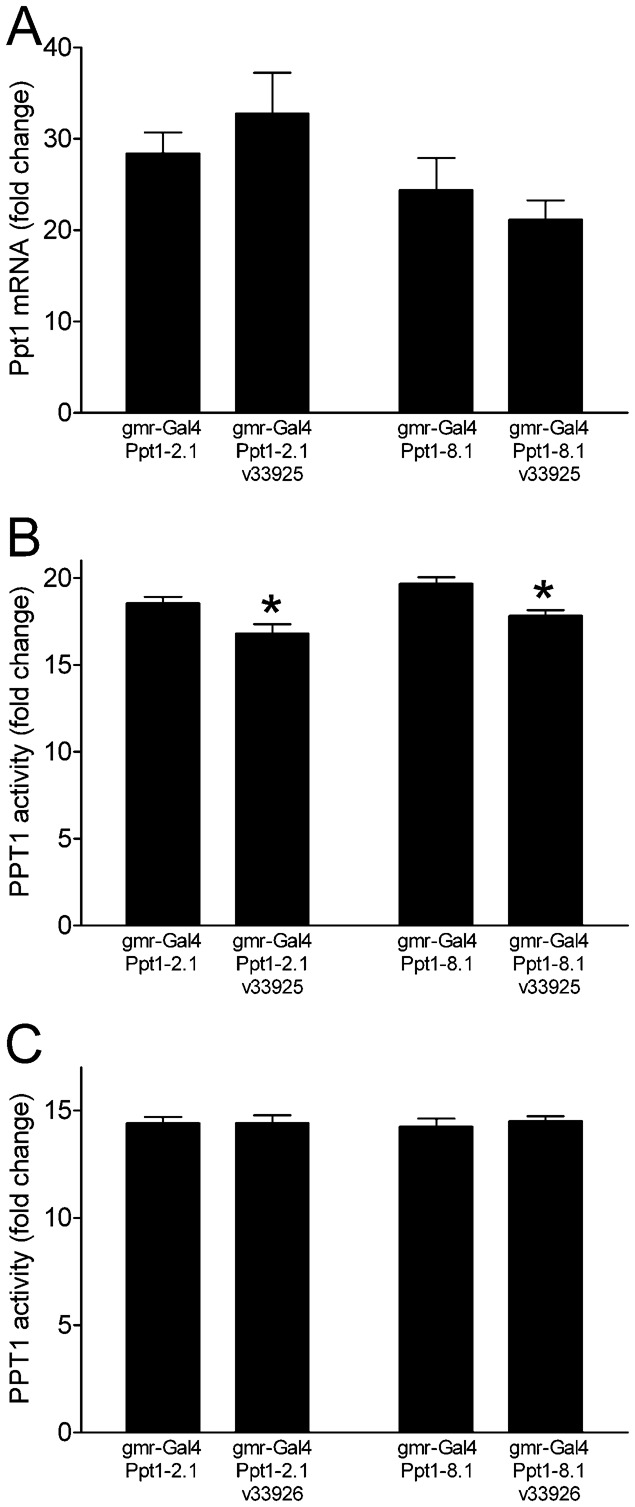
Effect of RNAi-mediated knockdown of cisd2 on Ppt1 mRNA expression and enzyme activity.(A) Expression of v33925 did not alter total head Ppt1 mRNA expression (individual t tests, n.s., n = 4). (B,C) PPT1 enzyme activity in fly heads. (B) Co-expression of the v33925 RNAi transgene with Ppt1-2.1 or Ppt1-8.1 decreased PPT1 enzyme activity (*individual t tests, n = 9 per genotype, p = 0.019 and p = 0.002, respectively). (C) Co-expression of the v33926 RNAi transgene with either Ppt1-2.1 or Ppt1-8.1 did not affect PPT1 enzyme activity (individual t tests, n = 17–18, n.s.). All data are presented as fold increases relative to endogenous Ppt1 mRNA or PPT1 activity in heads from gmr-Gal4/+ control flies.